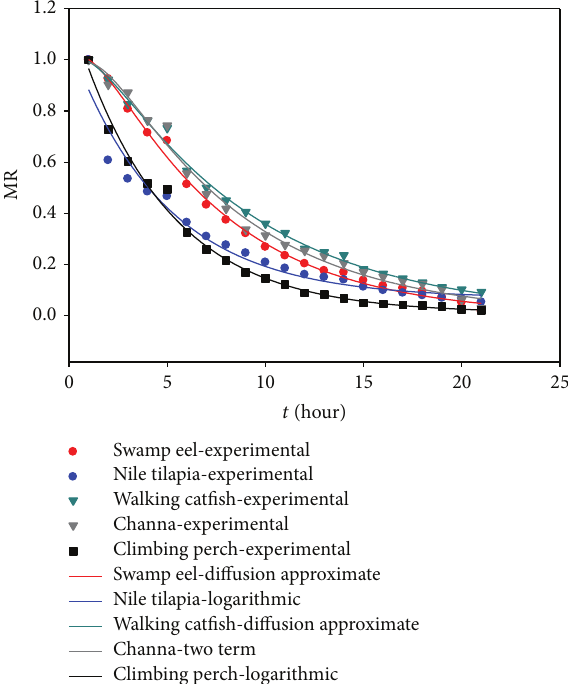
Figure 7: Experimental and predicted moisture ratio for solar drying of selected fish